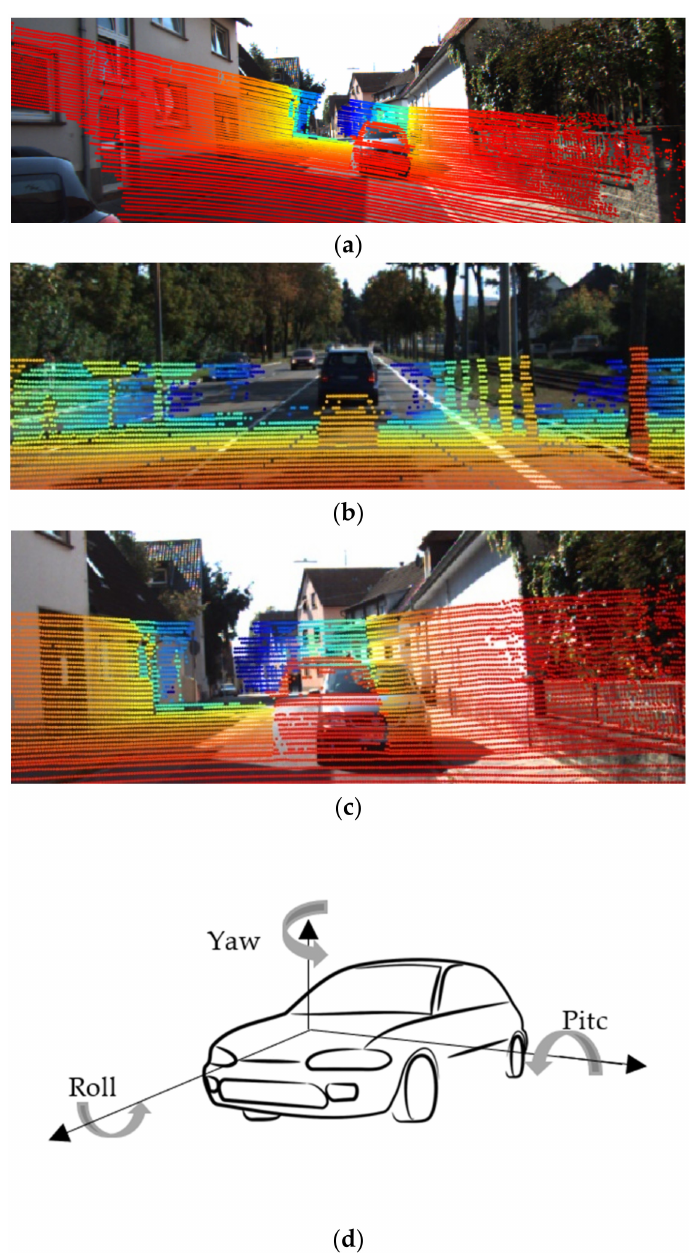
Figure 4. Roll ( a ), pitch ( b ), and yaw ( c ) introduced to the LiDAR–camera system. The color represents the distance. Subfigure ( d ) presents roll, pitch and yaw in the car coordinate system. The goal function F is defined as the mean value over relevant objects (i.e., objects that meet conditions of inclusion in the goal function) of the differences between